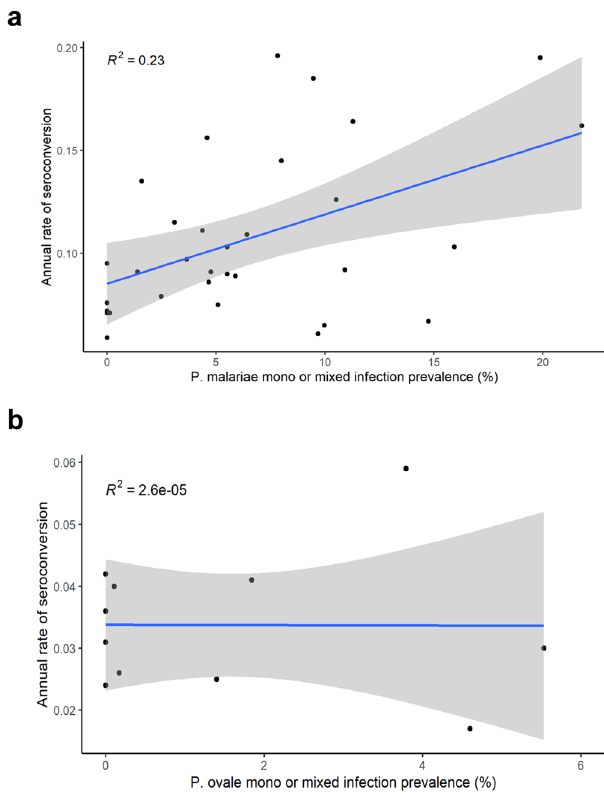
Fig.6|Correlationofactiveinfectionandserologicaldataforboth P.malariae and P. ovale : Nigeria, 2018. Association between infection prevalence of P . malariae ( a ) and P. ovale ( b ) infections per state and estimated annual ser- oconversion rate (SCR) by state to PmMSP1 and PoMSP1, respectively. Each point represents one state, blue line is the linear regression line of best fi t, shading indicates the standard error, and inset text the R 2 estimate. For PmMSP1, the ser- ocatalyticmodelconvergedfor86.5%(32/37)ofstatestoprovideaseroconversion rate, and for PoMSP1, the model converged for 29.7% (11/37) of